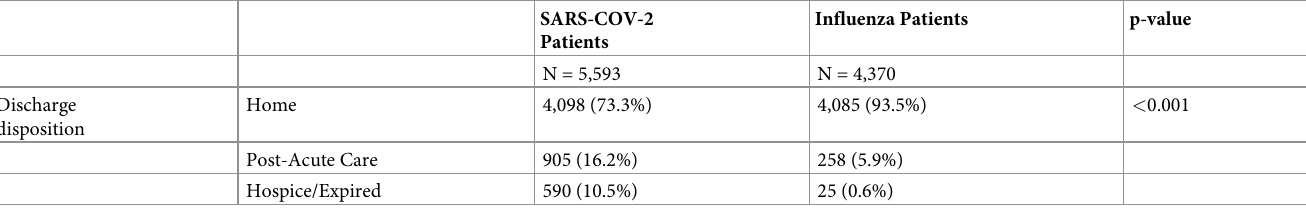
Table 7. Discharge dispositions of SARS-CoV-2 and influenza inpatient